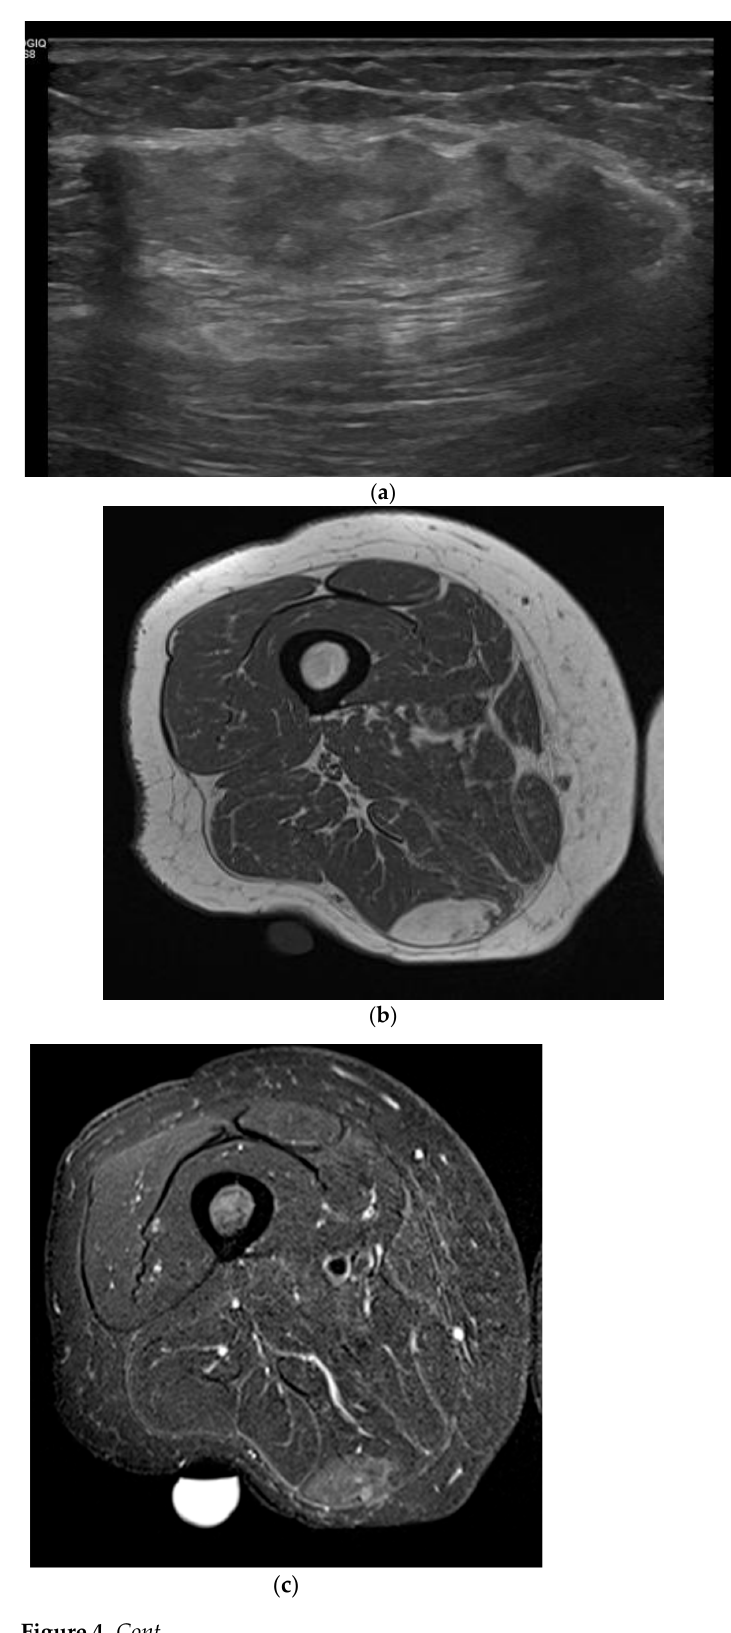
Figure 3. A 45-year-old man operated for a large MPNST with translocation t(X; 18) (p 11.2; q 11.2) and of genes SYT/SSX of the popliteal fossa shown by both US ( a ) and MRI ( b ). Follow-up did not show any changes consistent with relapse; only minor edema and fluid collection were present ( c ). Both MRI and US were reported negative for recurrence.